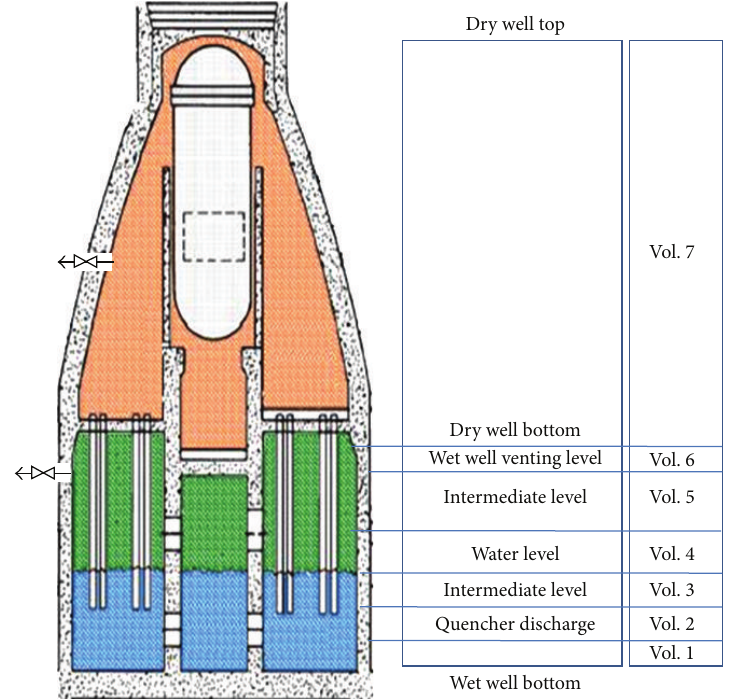
Figure 1: Simplified nodalization model of a BWR Mark II